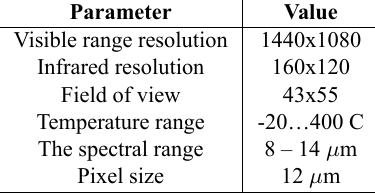
Table 1. FLIR One camera